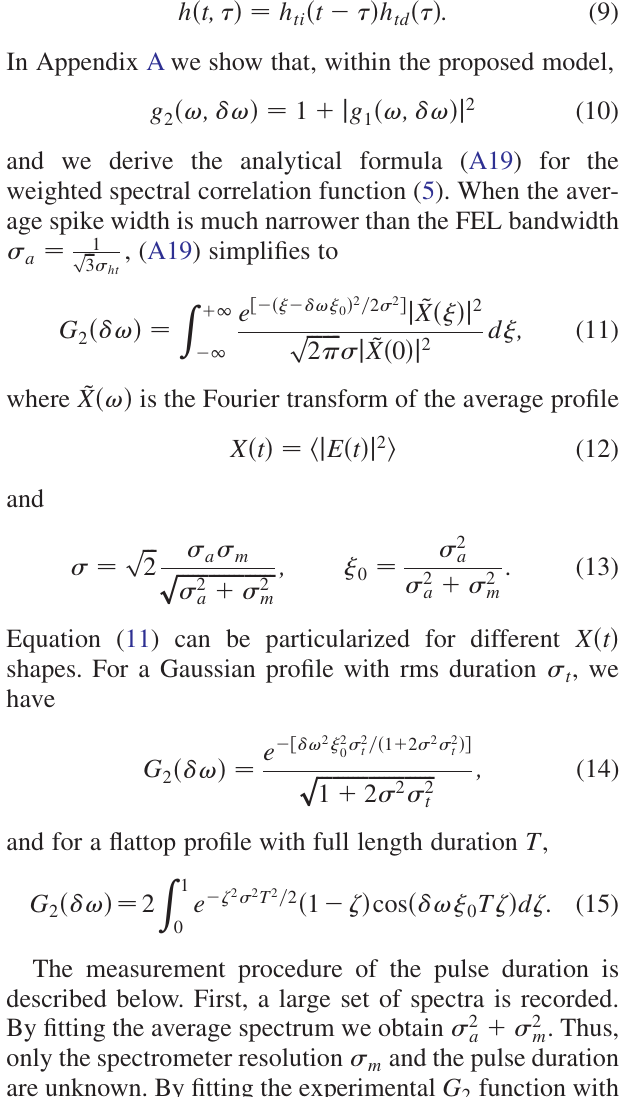
the measurement is insensitive to errors on (cid:2)